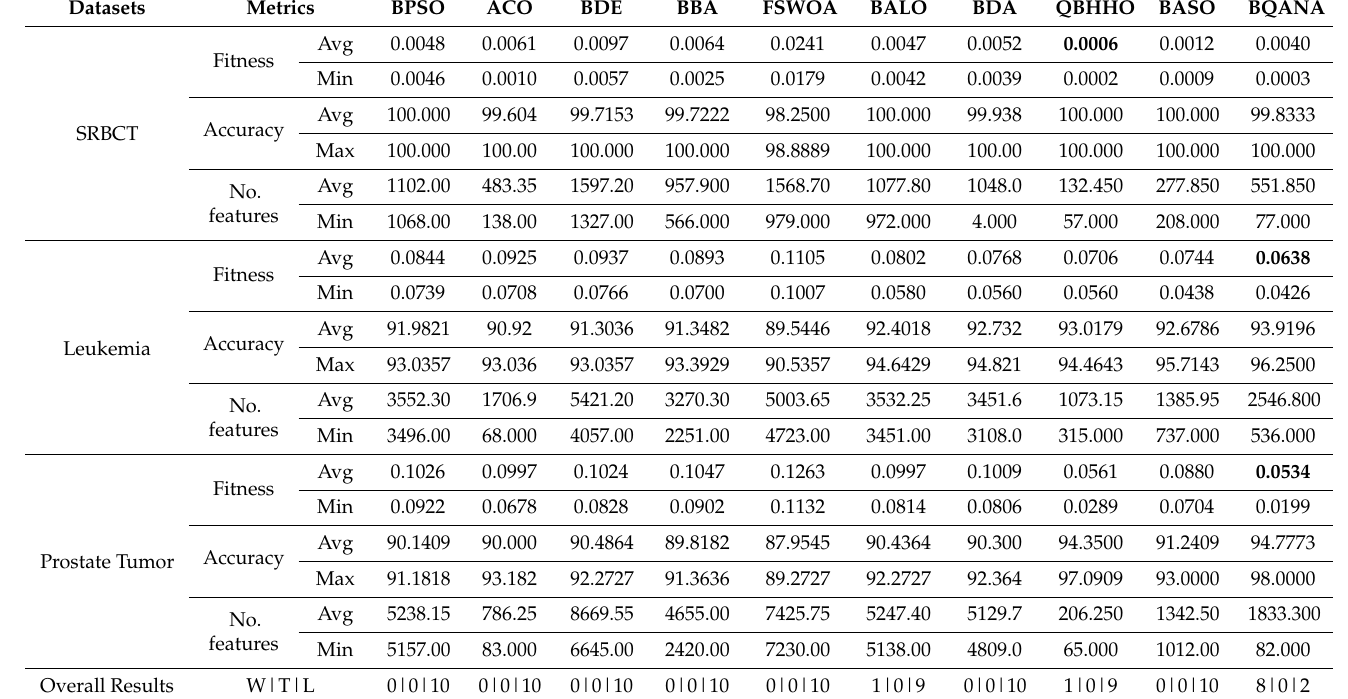
Figure 7. The average number of features selected by BQANA and comparative algorithms on me- dium and large datasets.